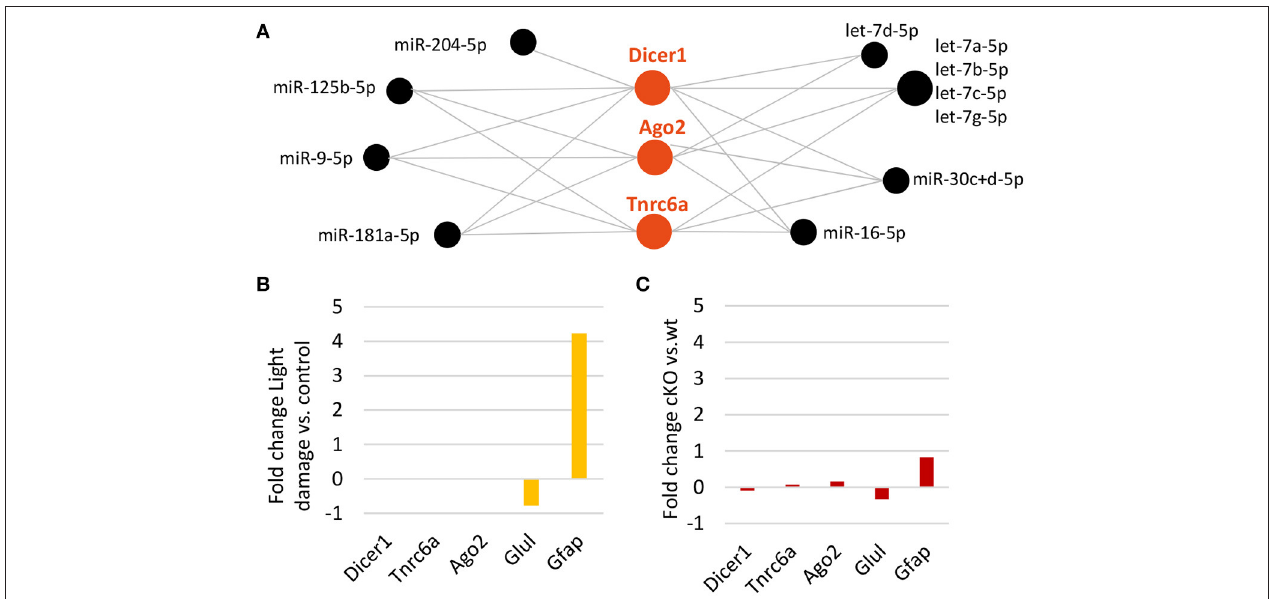
FIGURE 7 | Decline in Müller glia miRNAs does not affect Dicer or RISC. (A) DIANA-TarBase predicted/confirmed miRNAs regulating Dicer1, or members of the RNA-induced silencing complex (RISC) such as Argounate2 and or after Dicer deletion. (B) Expression levels (fold change of log 2 relative expression) of Dicer1 , RISC genes, Glul and Gfap MG genes (reference) after light damage vs. controls (five and six biological replicates, respectively, one technical replicate per condition). (C) Expression levels (fold change of log 2 counts per million) from RNA-seq of Dicer1 , Tnrc6a , Ago2 , Glul, and Gfap after Dicer deletion vs. wild type (14 and 20 biological replicates respectively, one technical replicate per